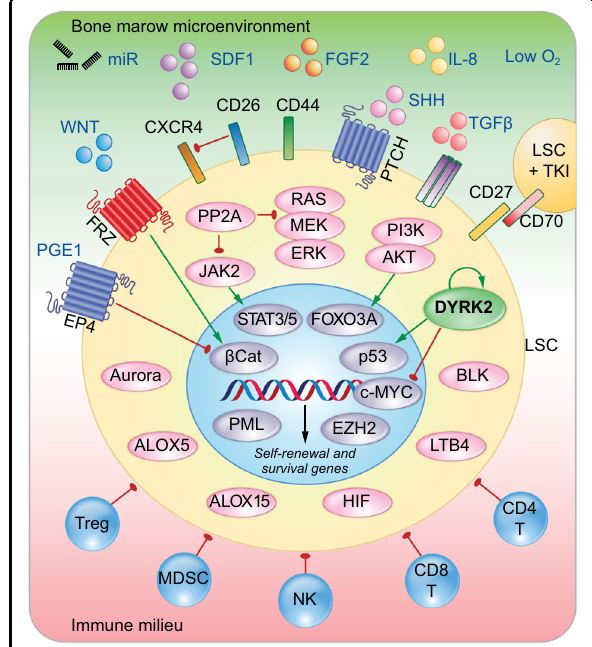
Fig. 2 Genetic regulation of leukemia stem cells in CML. Diagram depicting the main regulatory pathways controlling LSCs. The survival and self-renewal of CML LSCs are controlled through a combination of cell-extrinsic and cell-intrinsic factors. Several intracellular events have been described in LSCs, such as activation of kinases, phosphatases, lipid metabolism, and oxygen sensing, which lead to nuclear regulation of genes involved in LSC self-renewal and survival via epigenetic and transcriptional regulation mechanisms. In addition, external factors, such as the bone marrow microenvironment (proleukemic signals) and immune surveillance (antileukemic cells), collectively interact to support or inhibit LSC